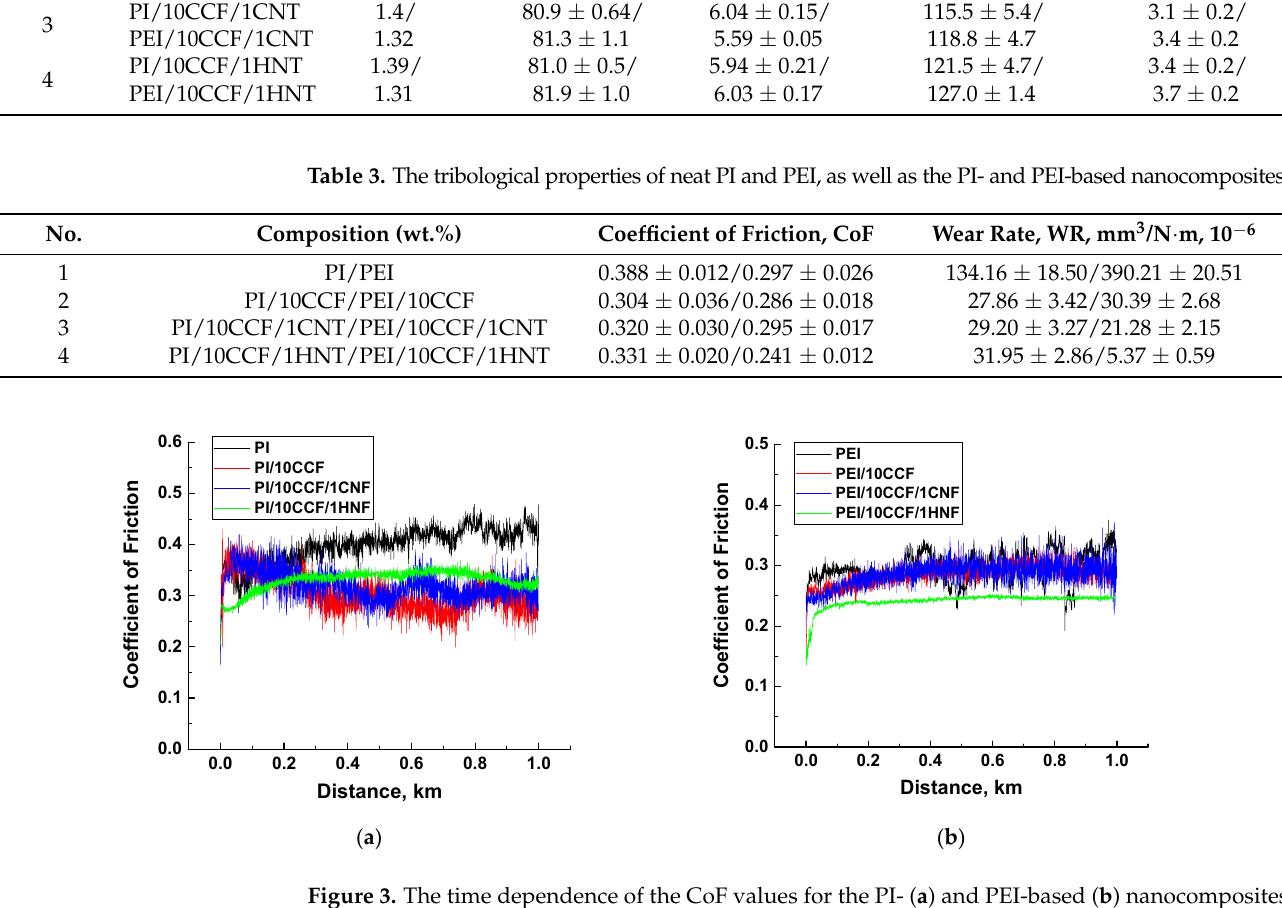
Figure 3. The time dependence of the CoF values for the PI- ( a ) and PEI-based ( b ) nanocomposites. Point tribological contact.